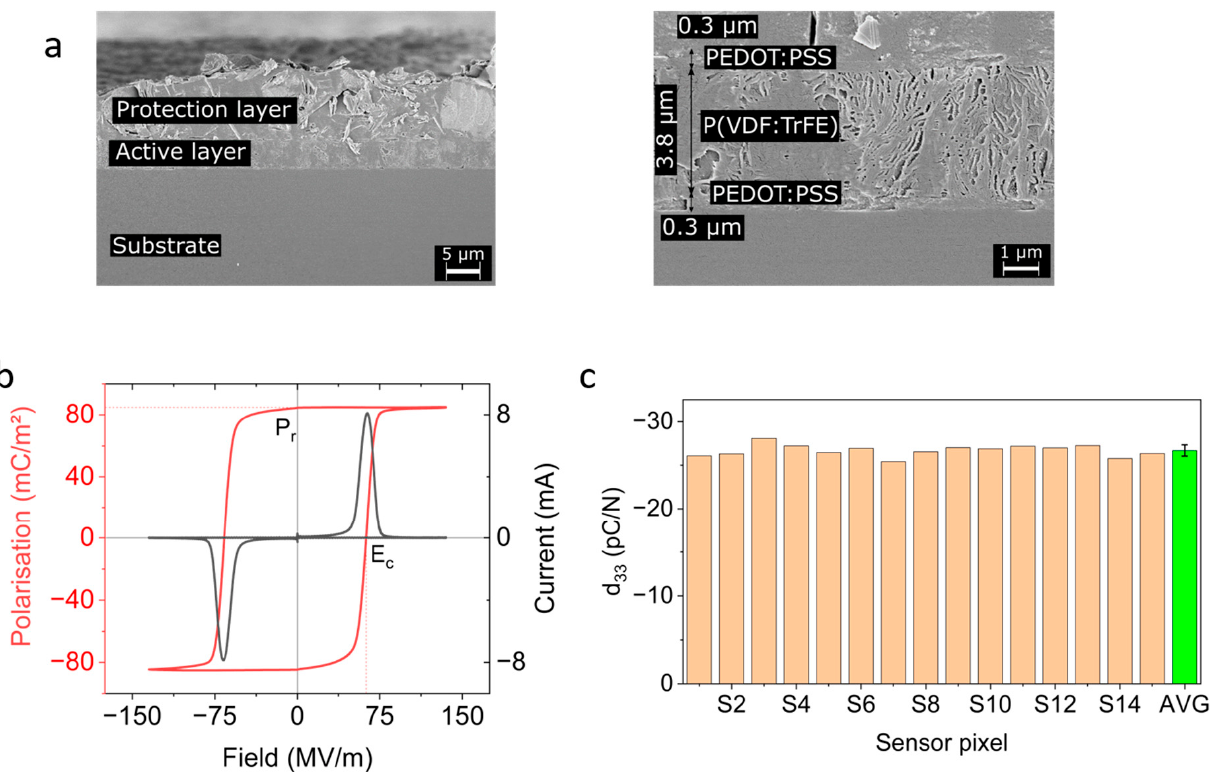
Figure 5. Characterization of the piezoelectric sensor pixels. ( a ) SEM image of the layer stack and enlarged view of the active layer comprising top and bottom electrodes and the ferroelectric P(VDF:TrFE) layer. The lamellar structure of P(VDF:TrFE) can be seen clearly. ( b ) Polarization (red line) and poling current (black line) of a single pixel, the composition of P(VDF:TrFE) was 80:20. Here, only a single period is shown. The polarization curve was obtained with the PUND method, and thus, the dielectric response is removed. Remnant polarization, P r , and coercive electric field, E c , are also indicated. The remnant polarization is the polarization at zero field and as indicated in the text, is related to the strength of piezoelectric response. The coercive field is the field at which the polarization changes sign. The poling procedure is performed up to twice the coercive field, E c , to ensure saturation of the polarization. ( c ) Apparent d 33 piezoelectric parameter for each pixel (“S1” through “S15”) and average value of the whole device (“AVG”). The error bar indicates the standard deviation of the average.